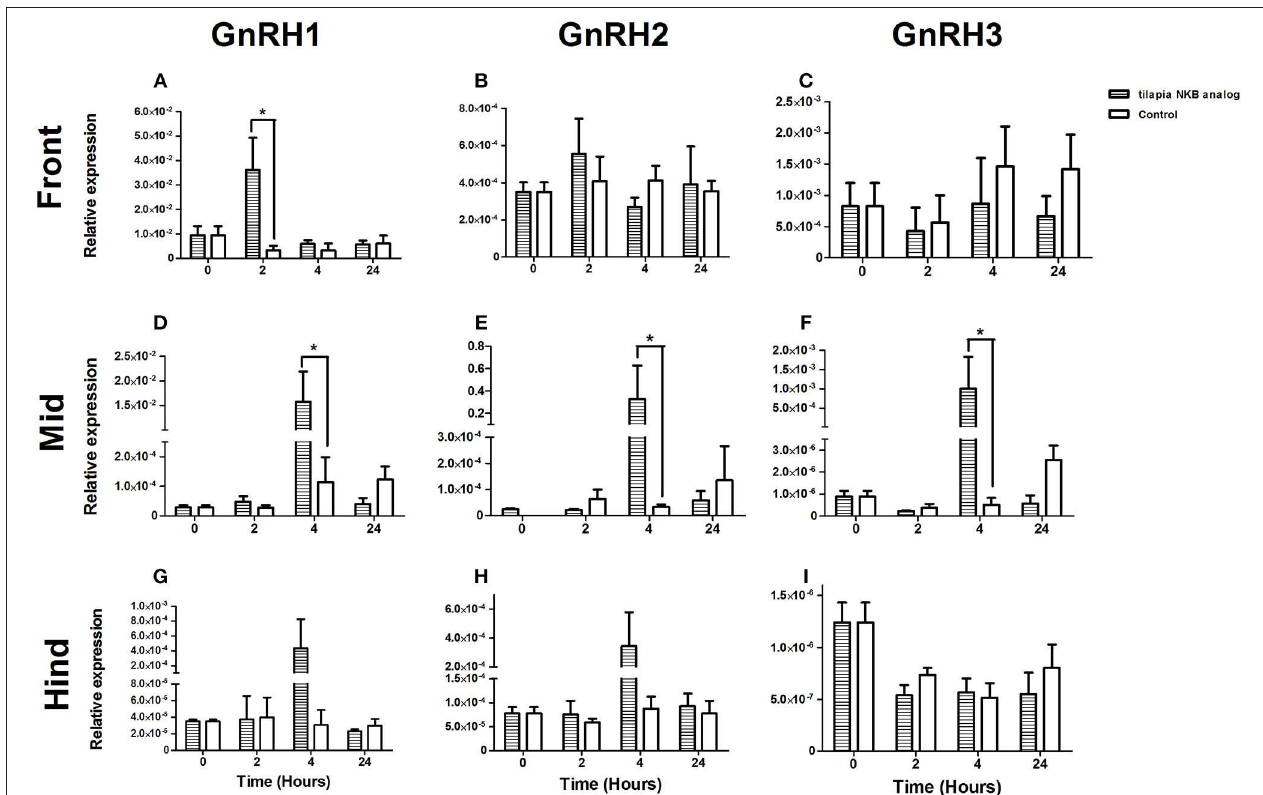
FIGURE 6 | mRNA levels of GnRH1 (A,D,G) , GnRH2 (B,E,H) , and GnRH3 (C,F,I ) in specific parts of the tilapia brain (front, mid, and hind) in response to IP injection of tiNKB analog (100 µ g/kg BW). The relative abundance of the mRNAs was normalized to the amount of 18s by the 11 CT cycle method. Results are expressed as mean ± SEM ( n = 4–5 fish/group). * p < 0.05 one-way ANOVA followed by